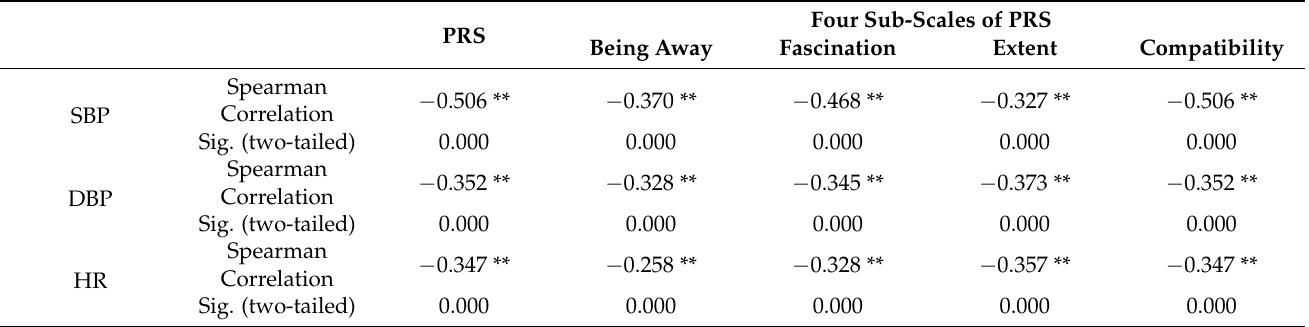
Four Sub-Scales of PRS PRS Being Away Fascination